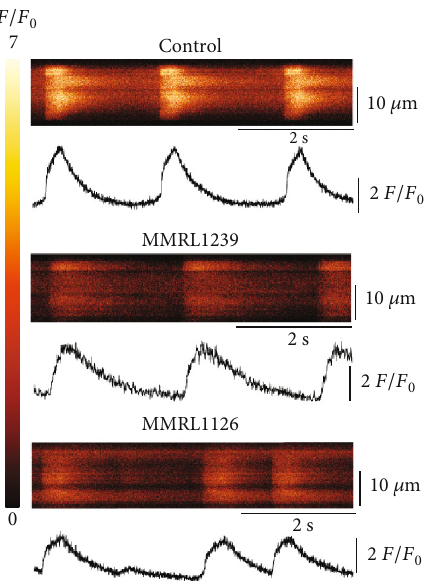
Figure 4: Line scans recorded from WT, MMRL 1239, and MMRL1126 hiPSC-CMs showing spontaneous Ca 2+ transients in all hiPSC-CMs. However, fl uorescence intensity was much lower in MMRL 1126, and spontaneous activity was episodic in